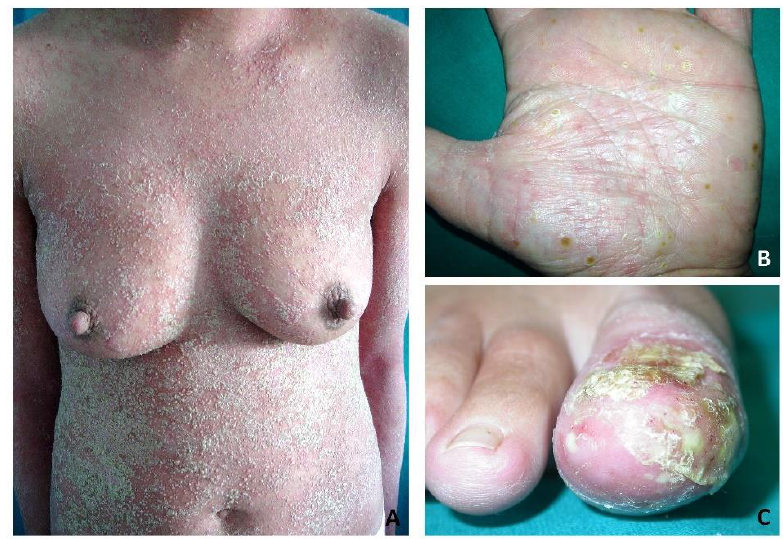
Figure 2. Clinical presentation of three forms of pustular psoriasis. Generalized pustular psoriasis showing diffuse erythroderma covered by confluent pustules coalescing into pustular lakes ( A ). Palmoplantar pustulosis showing pustular lesions involving the palmar area ( B ). Typical lesions of acrodermatitis continua of Hallopeau involving the toe and leading to the destruction of the nail apparatus ( C ).